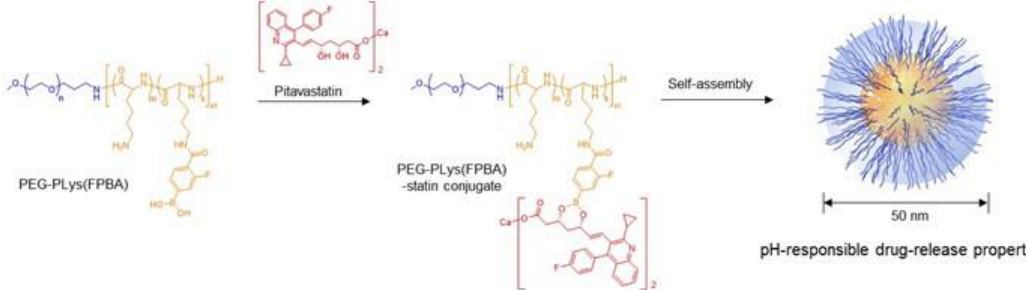
Figure 1. Schematic illustration of block-copolymer (blue = poly(ethylene glycol) segment, yellow = poly( L -lysine)-phenylboronic acid segment) and statin (red)-loaded polymeric micelles.